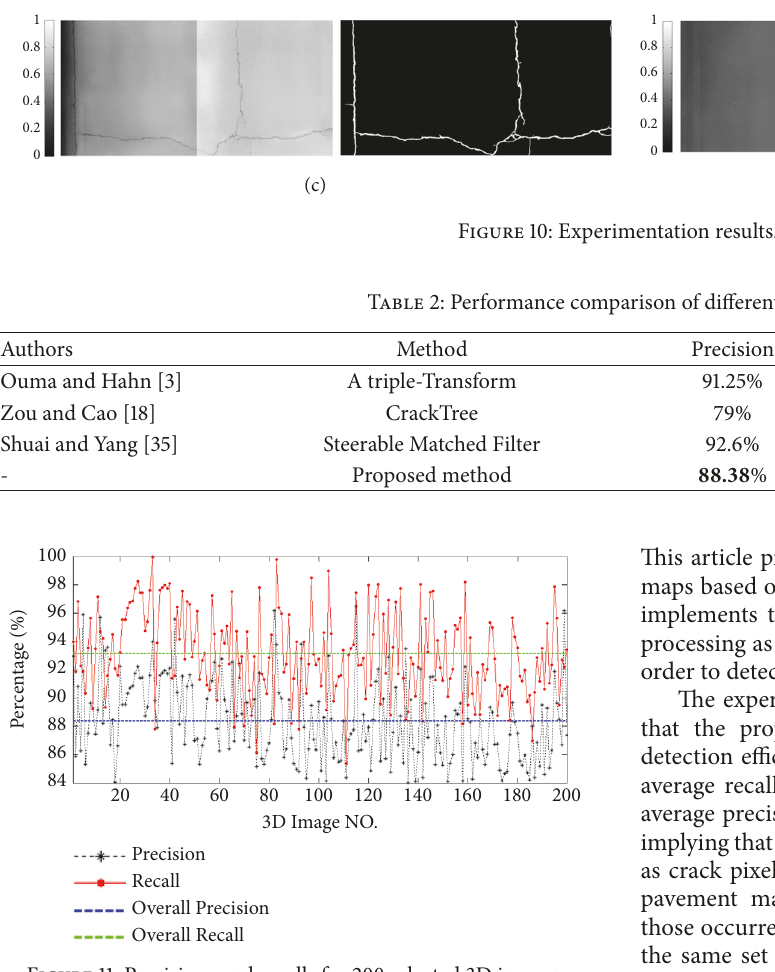
Figure 11: Precisions and recalls for 200 selected 3D